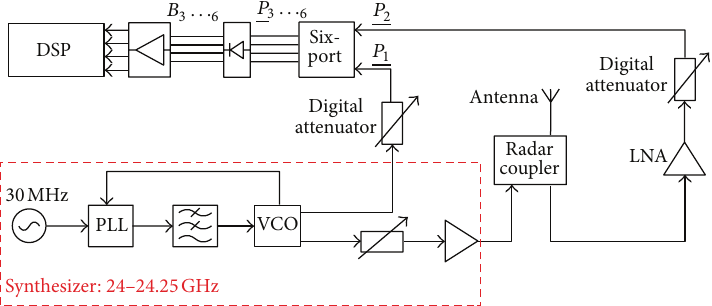
Figure 2: Schematical view of the radar front-end.